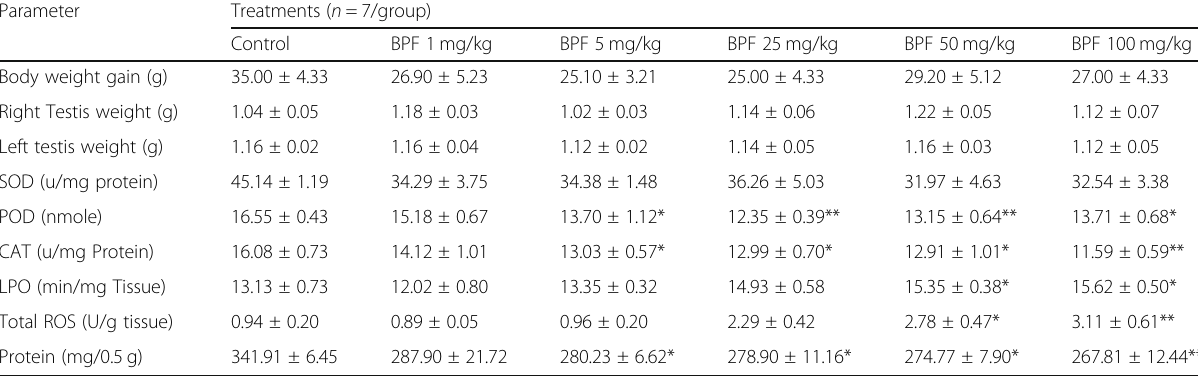
Table 2 In vivo effect of subchronic Bisphenol F (BPF) on the different parameters